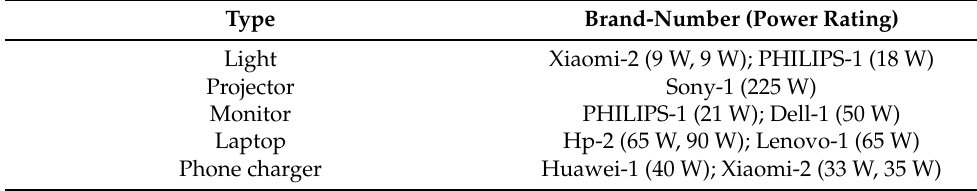
Table 2. Appliances used in preliminary study and evaluation.